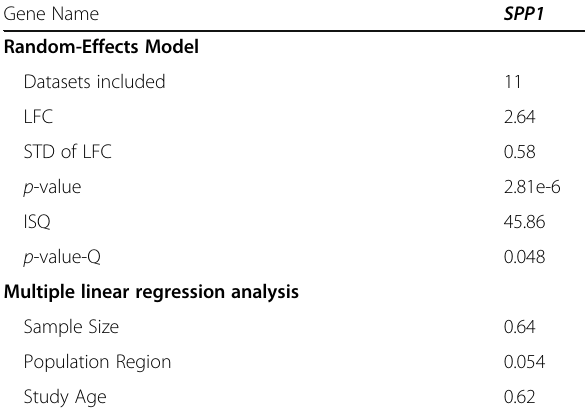
Table 2 SPP1 mega-analysis and regression analysis